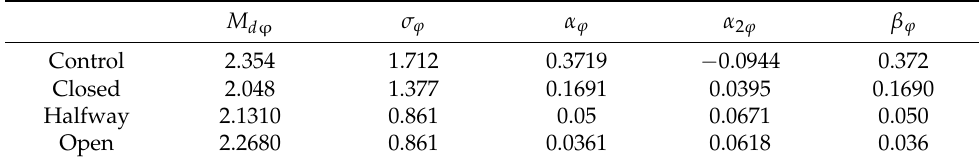
Table 5. Estimated parameters of the no shroud test for combined